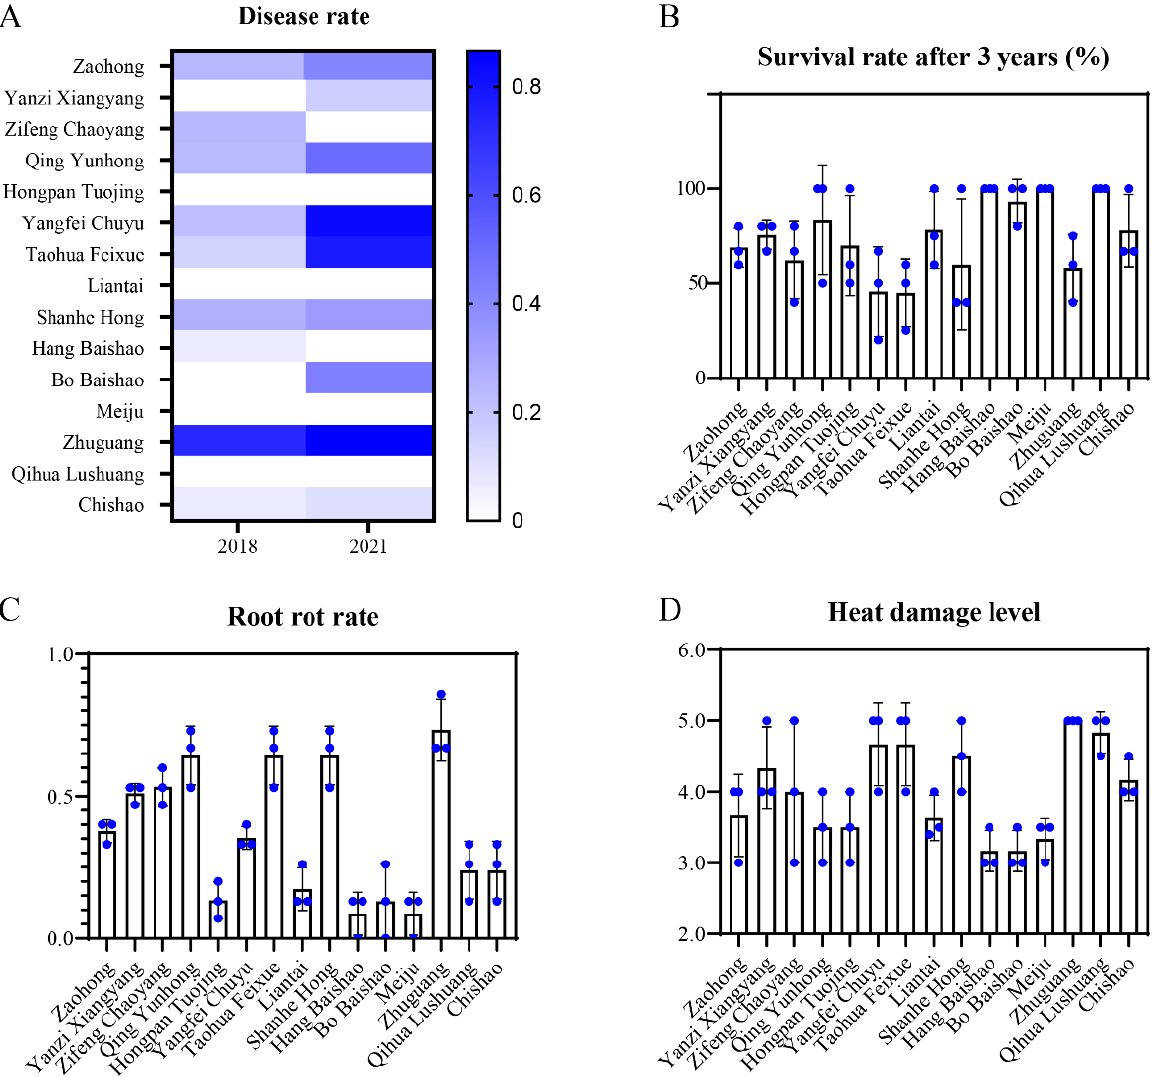
Figure 2. Observations and changes of adaptability-related indices of the fifteen peony cultivars. ( A ) Disease rate; ( B ) Survival rate after three years; ( C ) Root rot rate; ( D ) Heat damage level. Values represent the means± standard deviation of three replicates.